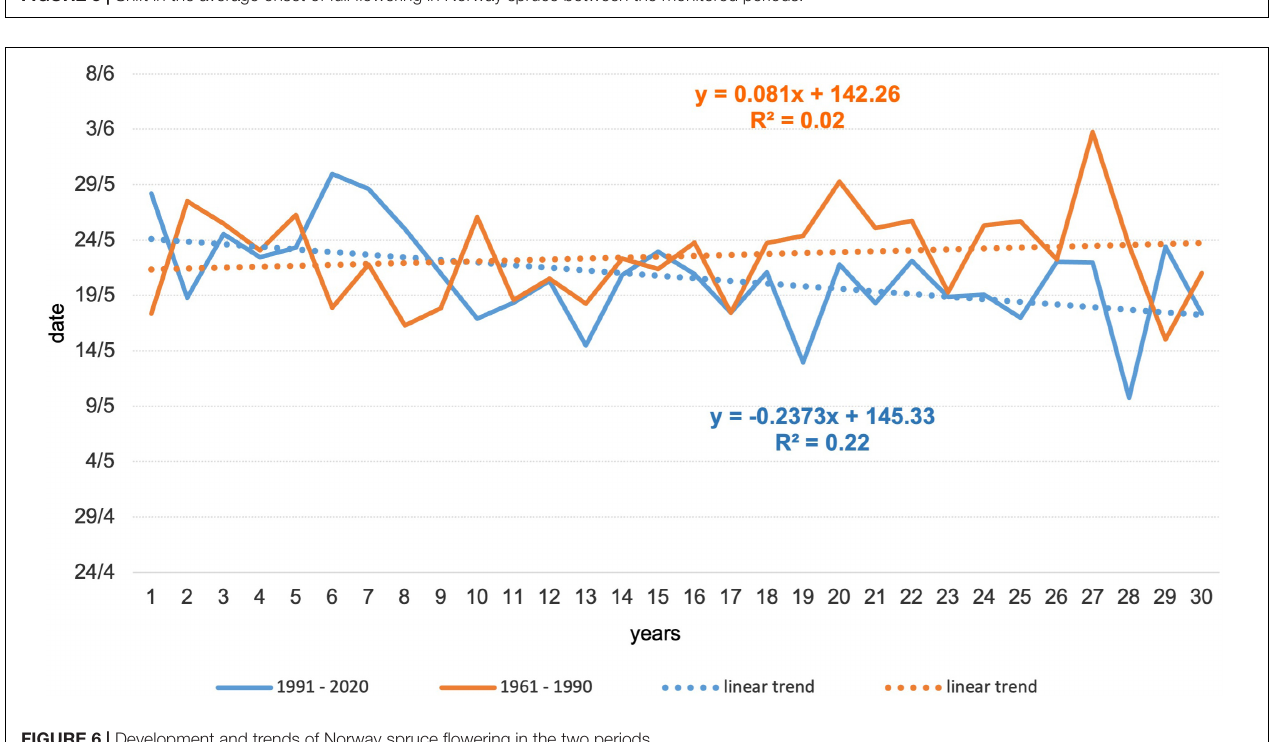
period 1970–1978 represented the longest period of above- average January temperatures in a row. Deviations from the climatological normal ranged from 0.72 to 4.51 ◦